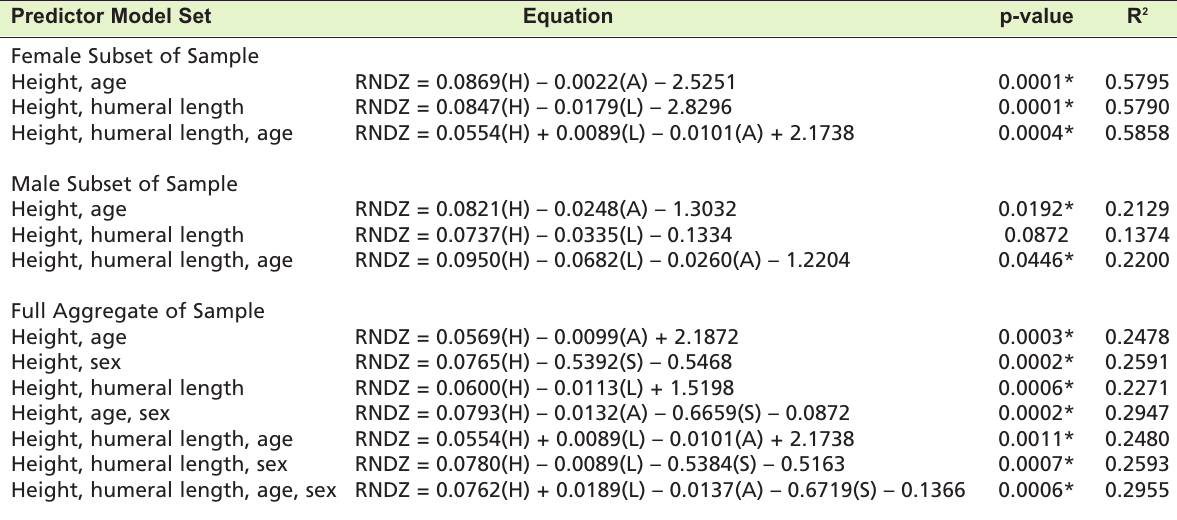
Multivariate regression model building results with danger zone as the dependent variable Table III: